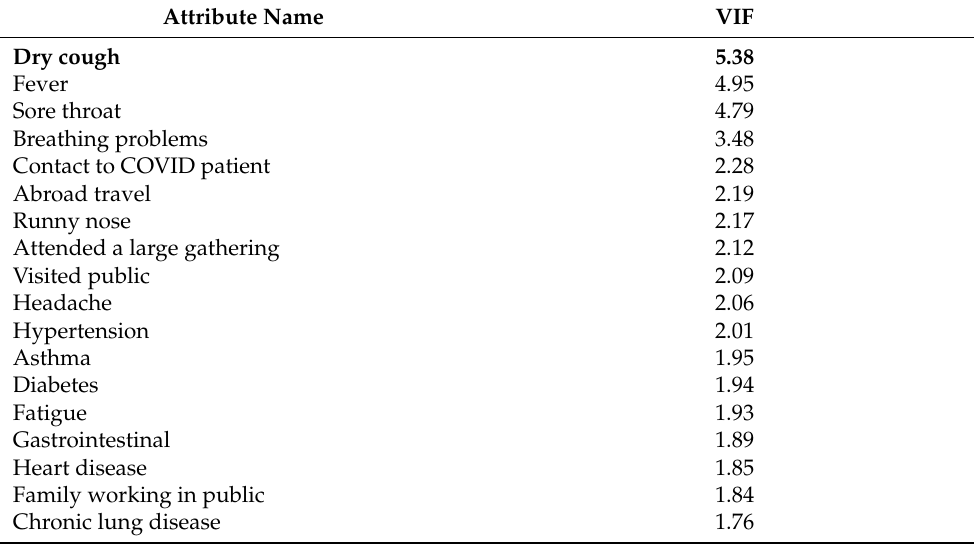
Table 4. VIF of predictors in the dataset.